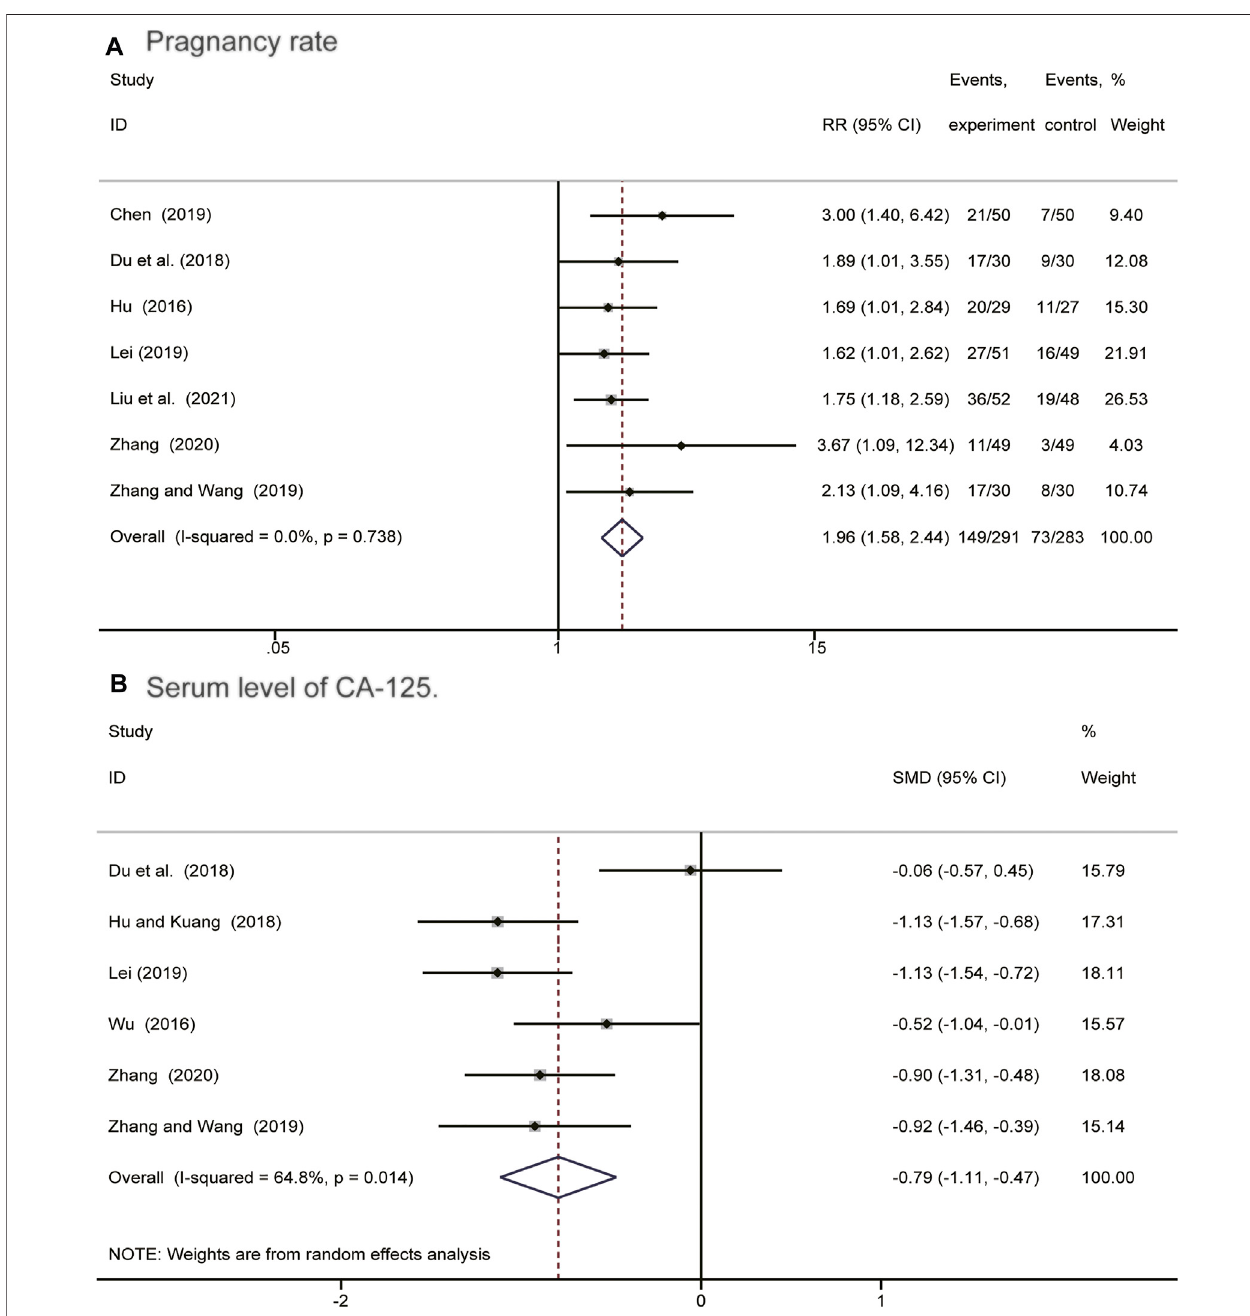
FIGURE4| Forest plotsshowingcomparision ofpregnangcyrate (A) and serum level ofCA-125 (B) comparing Salvia -containingCHMcombined withGnRH-a to GnRH-a alone treatment.